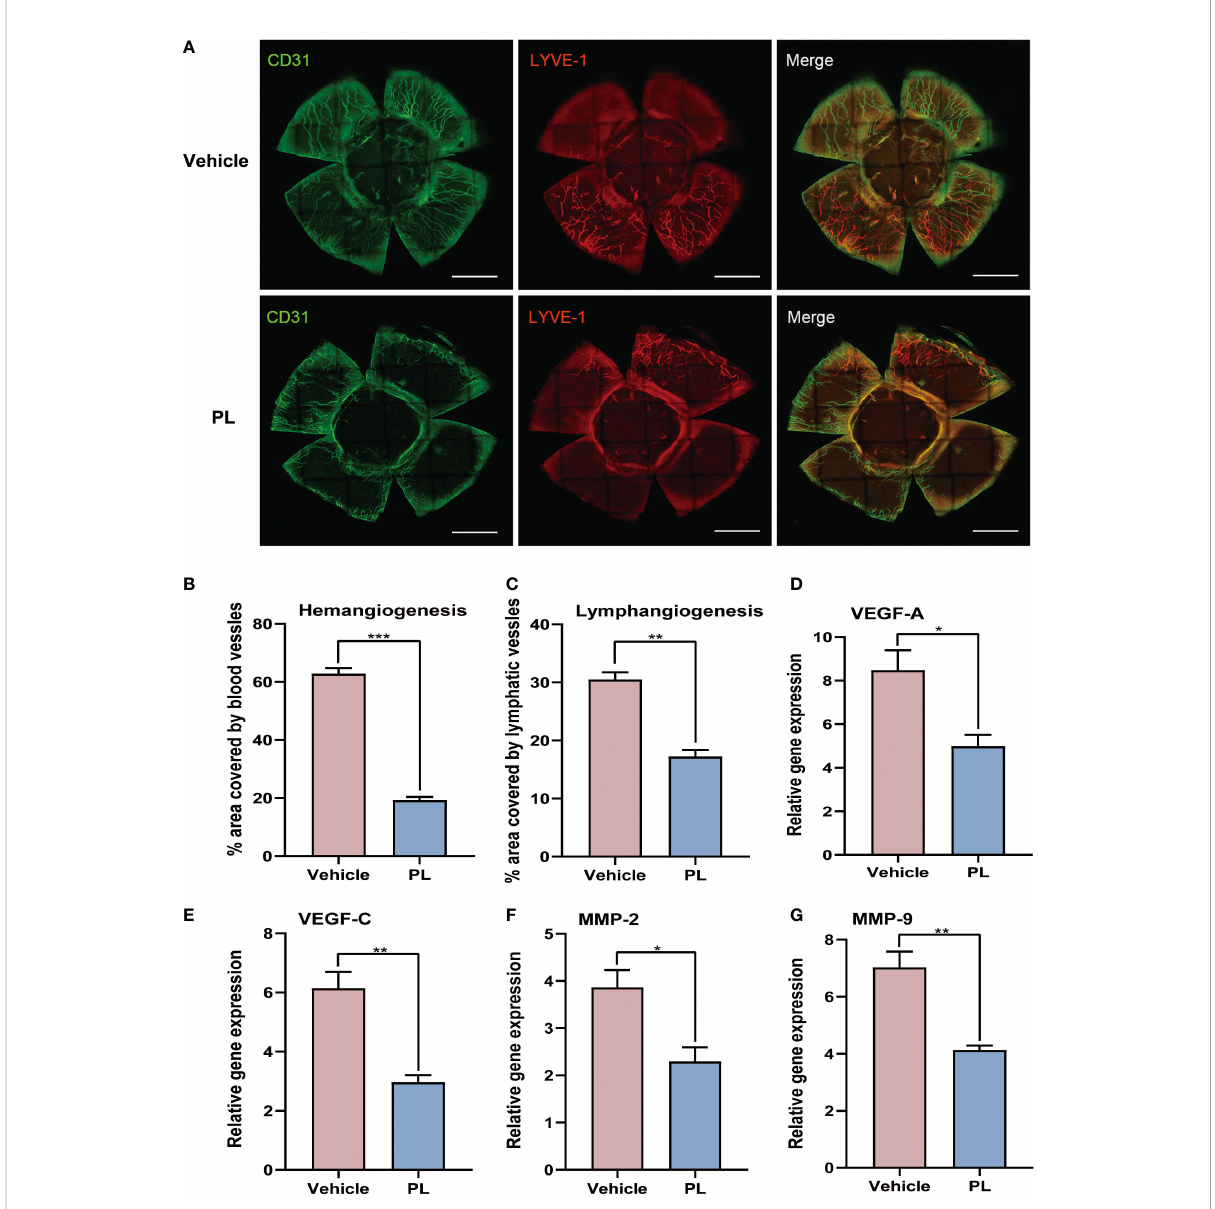
FIGURE 2 PL suppressed coNV in murine corneal allograft transplantation model. (A) Representative immuno fl uorescence of corneal fl at mounts showing ingrowth of CD31 + blood vessels and LYVE-1 + lymphatic vessels from vehicle-treated group and PL-treated group on postoperative day 14. (B, C) Statistical quanti fi cation of the area covered by CD31 + blood vessels (B) and LYVE-1 + lymphatic vessels (C) from two groups on postoperative day 14 (n = 4/group). scale bar 1 mm. (D-G) The mRNA levels of several pro-angiogenic and pro-lymphangiogenic factors were determined by qRT-PCR (n = 6/group). Data were normalized to the expression of these genes in untreated BALB/c mice. * P < 0.05, ** P < 0.01, *** P <